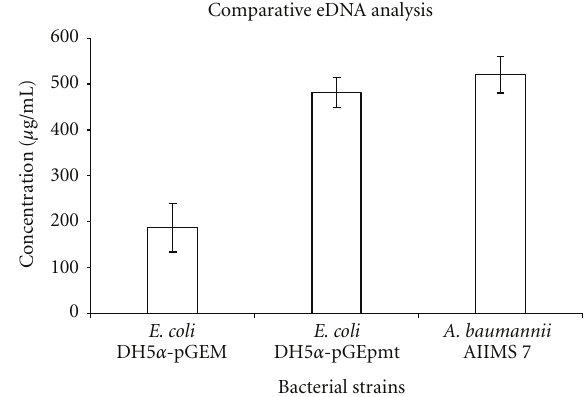
Figure 10: Quantitative analysis of eDNA production during in vitro